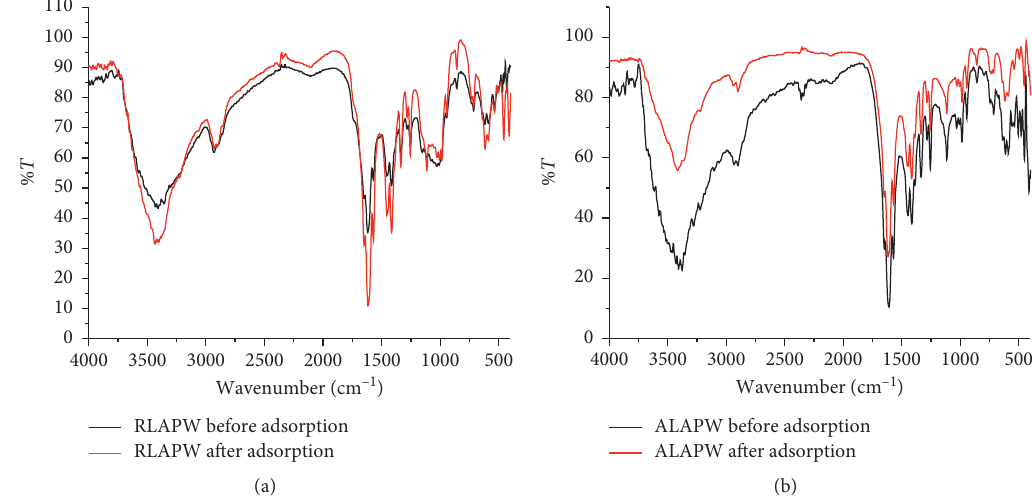
Figure 3: FT-IR spectra of LAPW adsorbents before and after adsorption of MG